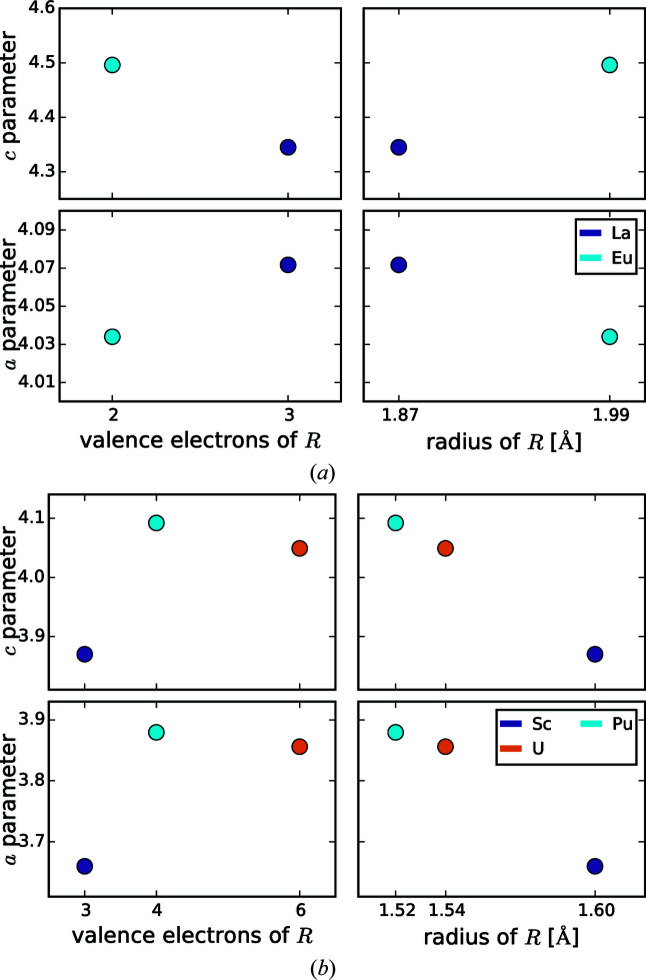
Influence of the valence electron amount on the lattice parameters of AlB2-like RSi2 and R
2
TSi3 compounds, for R elements with similar radii and constant T element. (a) R
h, 1 = La, Eu, T = Ni and (b) R
h, 2 = Sc, U, Pu, T = Si.